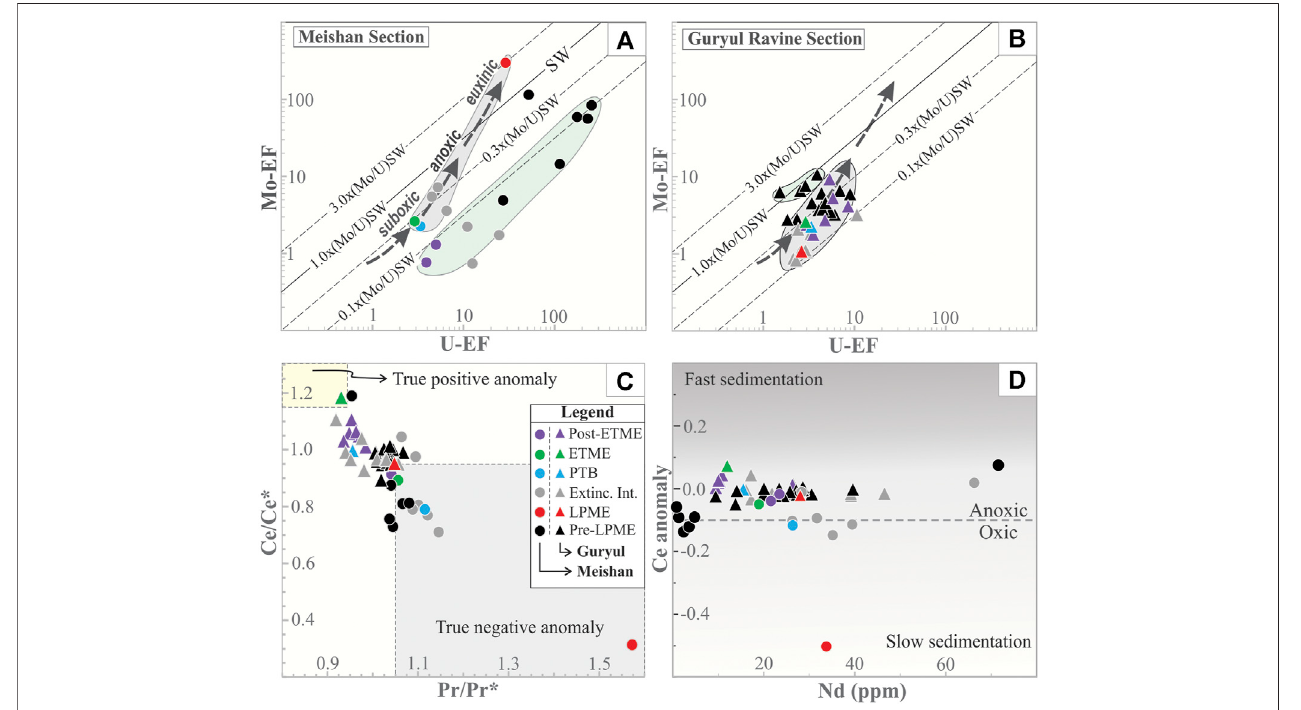
FIGURE 3 | (A – B) Mo EF vs. U EF covariation for the Meishan D and Guryul Ravine sections (based on Tribovillard et al., 2012; Sosa-Montes et al., 2017), in which Mo EF (cid:1) [(Mo/Al) sample /(Mo/Al) PAAS ] and U EF (cid:1) [(U/Al) sample /(U/Al) PAAS ]. The PAAS composition used is from Taylor and McLennan (1985). The diagonal lines represent multiples of the Mo/U ratio of present-day seawater. The general pattern of Mo EF vs. U EF covariation in unrestricted marine trend for modern eastern tropical Paci fi c is from Tribovillard et al. (2012), modi fi ed by Sosa-Montes et al. (2017) (C) Crossplot of Ce/Ce* vs. Pr/Pr* for the Meishan and Guryul Ravine sections (after Bau and Dulski, 1996) (D) log(Ce/Ce*) vs. Nd (ppm) plot for both sections (modi fi ed from Wang et al., 2014).